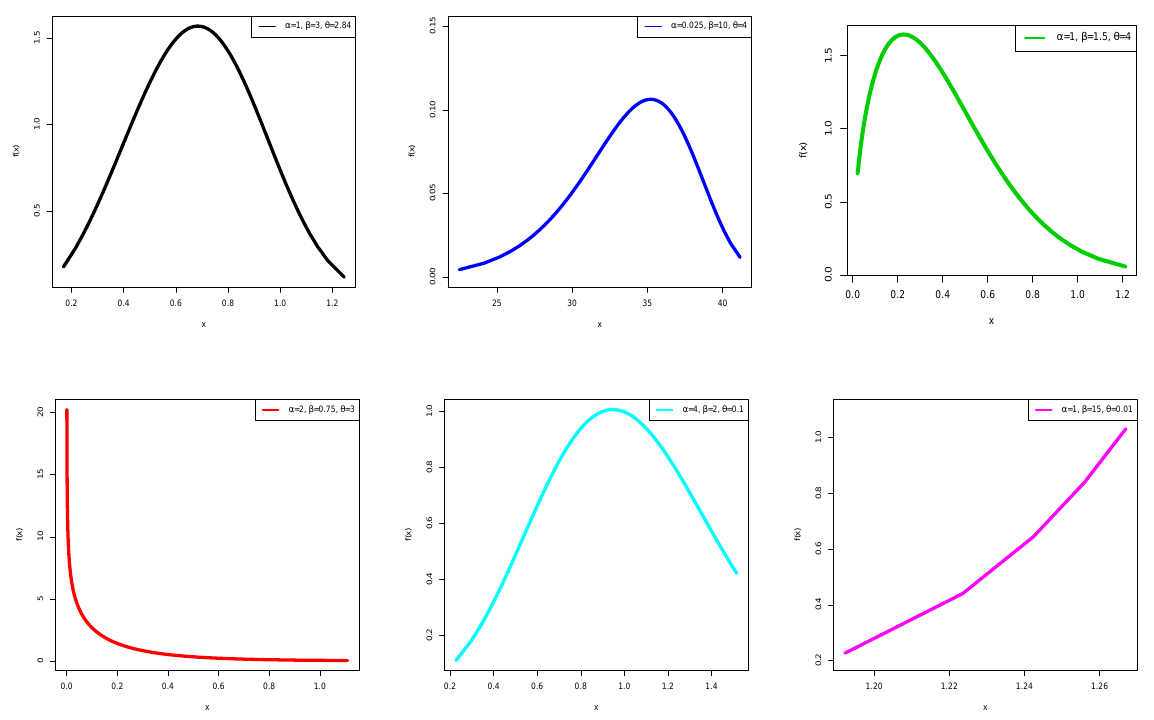
Figure 1 - Plots of the LiW pdf for selected parameter